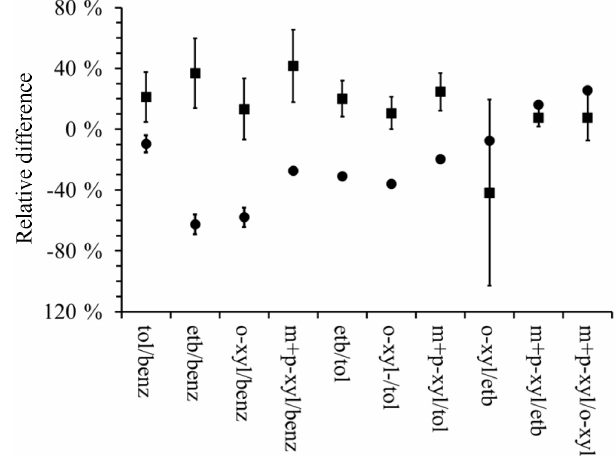
Figure 10. Relative difference between the average of all VOC concentration ratios (molmol − 1 ) and the average VOC concentra- tion ratios for VOC with carbon isotope ratios that are not higher than the carbon isotope ratios of emissions (95% confidence limit) (squares). The circles show the relative change expected for a uni- form R [OH]d t calculated from the average R [OH]d t of all observa- tions (Table 13). The error bars show the standard error calculated from error propagation. For data points with error bars smaller than the size of the data point, no error bars are